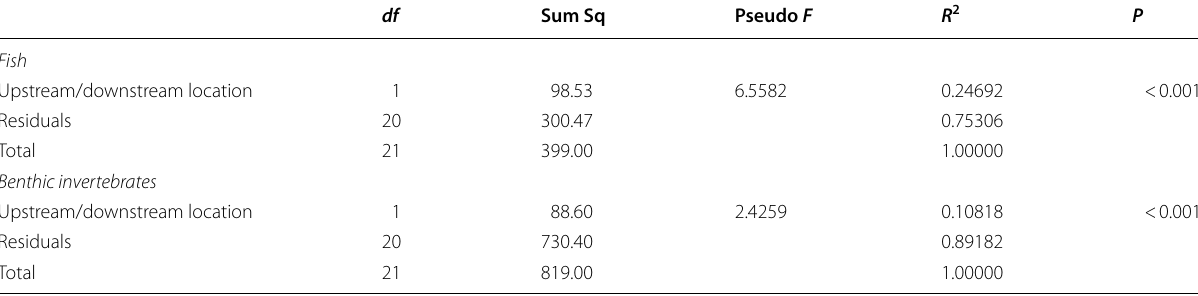
P values based on 999 permutations